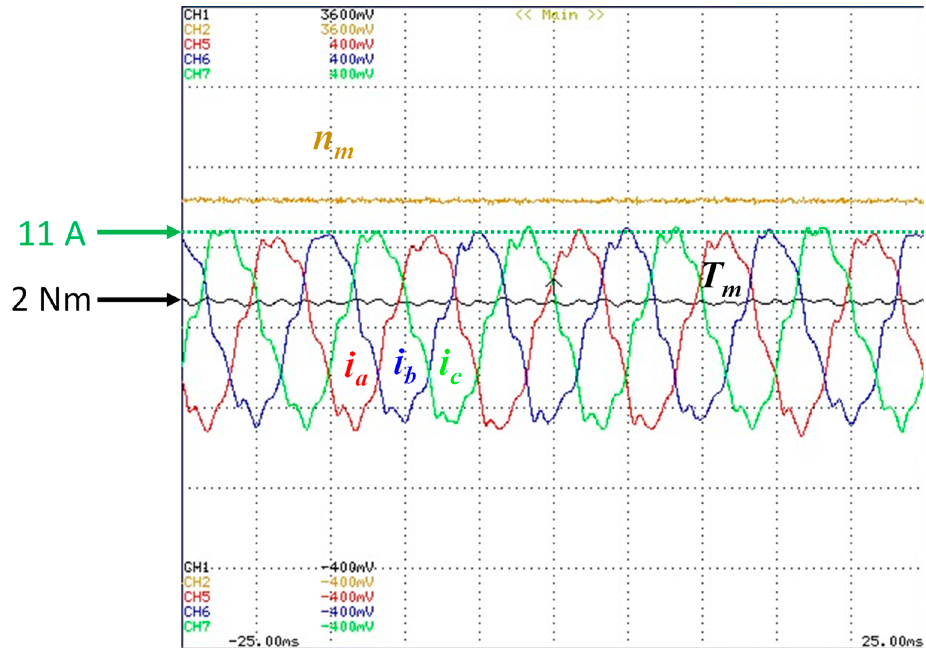
Figure 12. Experimental results obtained for the traction system operating at a constant speed (1500 rpm) without a load: the torque ( T m ) and speed ( n m ) of the SRPM machine; the stator windings’ currents ( i a , i b , i c